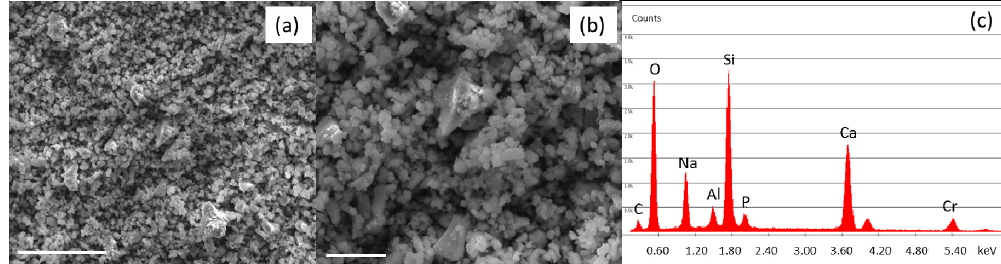
Figure 1. Scanning electron microscopy (SEM) ( a , b ) and energy dispersive x-ray spectrometry (EDS) ( c ) analysis of SBA2 powders after milling process. Scale bars: 40 µm (a), 10 µm (b). ( c ) analysis of SBA2 powders after milling process. Scale bars: 40 µ m ( a ), 10 µ m ( b